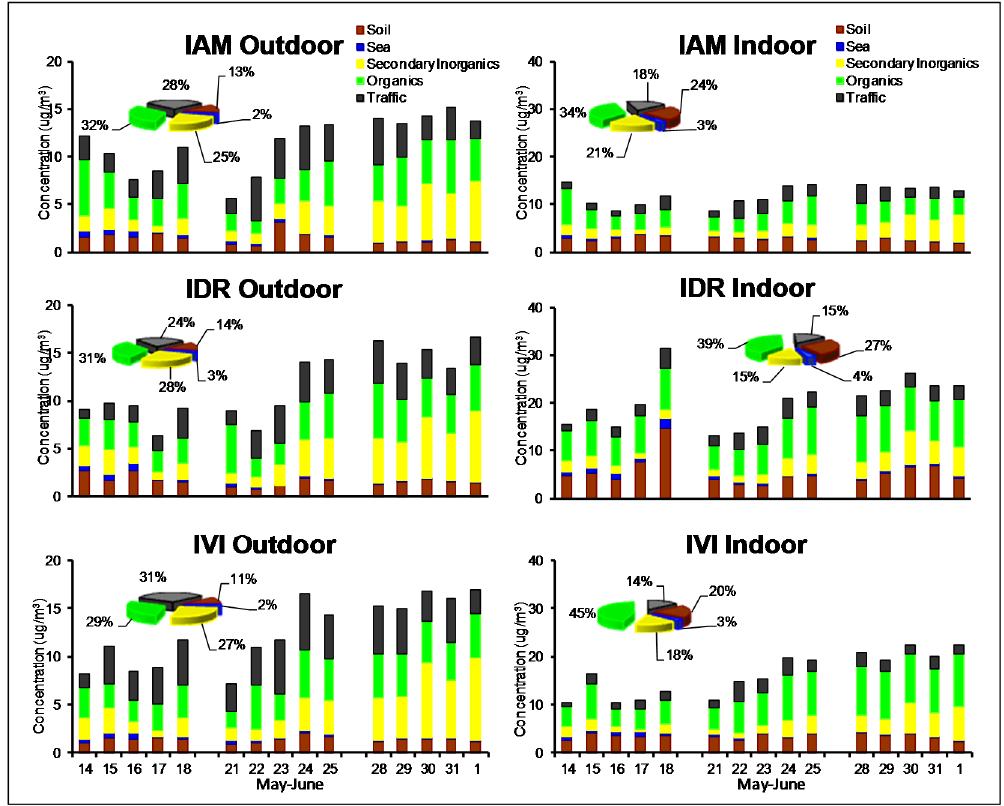
Figure 5. Outdoor and indoor daily contributions of the five macro-sources (histograms) and average composition of PM 2.5 (pie charts) during the spring/summer